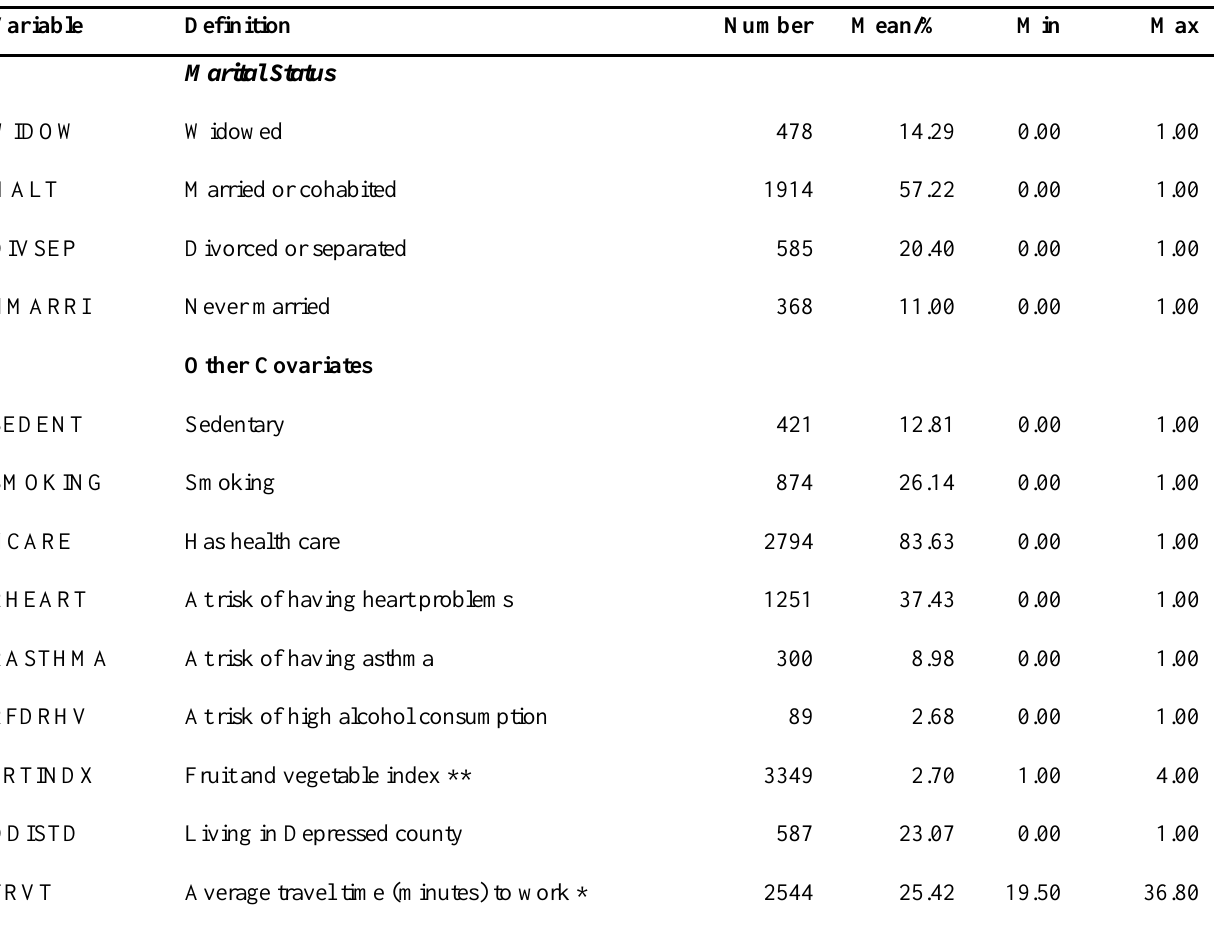
Table 2. Descriptive statistics for marital status and other